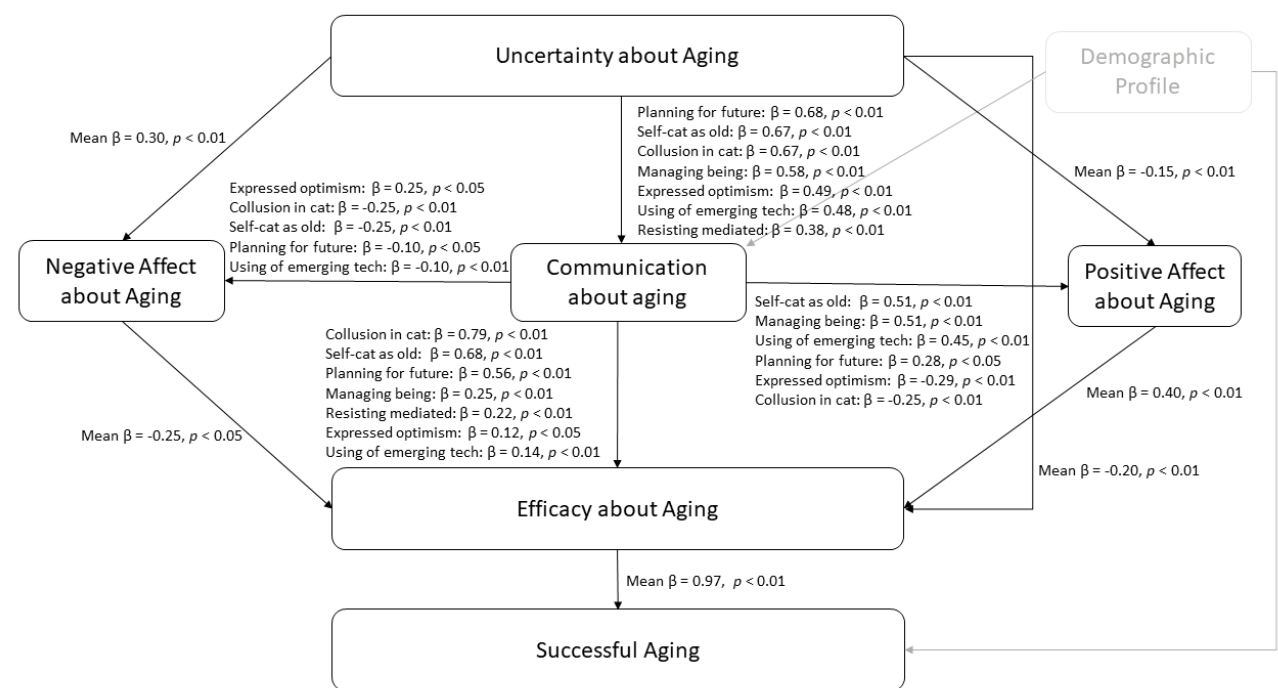
Figure 2. Results of Hypothesis 1 (H1)—Hypothesis 5 (H5).